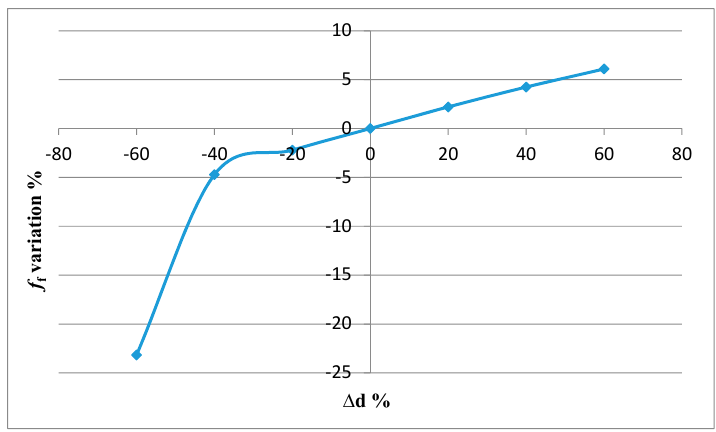
Figure 19. Sensitivity of diameter reduction vs. f f .